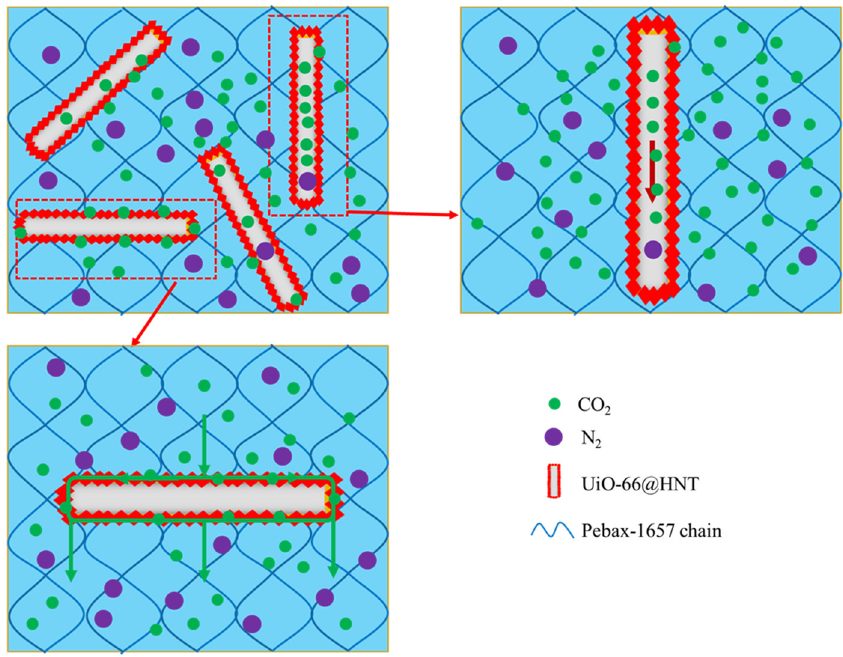
Figure 10. Schematic diagram of the gas permeation mechanism of UiO-66@HNT/Pebax membranes.